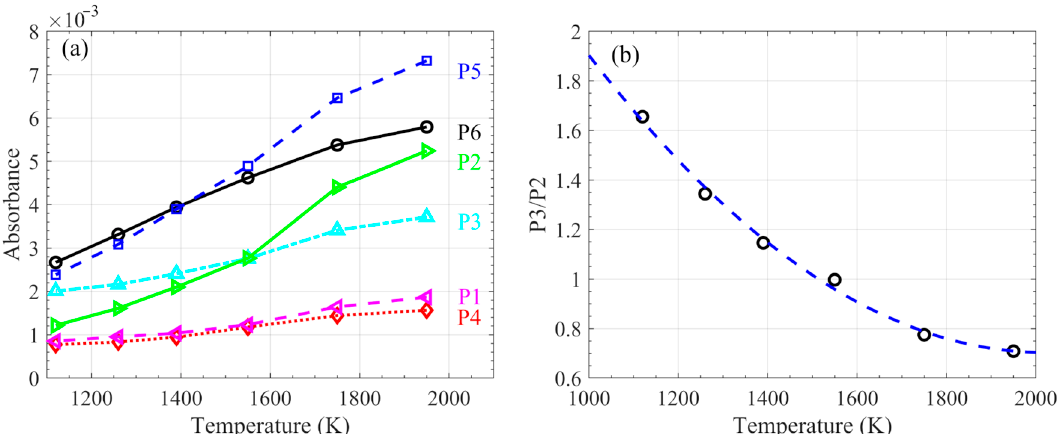
Figure 6. Absorbance of H 2 O at line peaks P1–P6 (as labeled in Figure 5) ( a ), and the ratio of P3 to P2 ( b ), as a function of temperature.